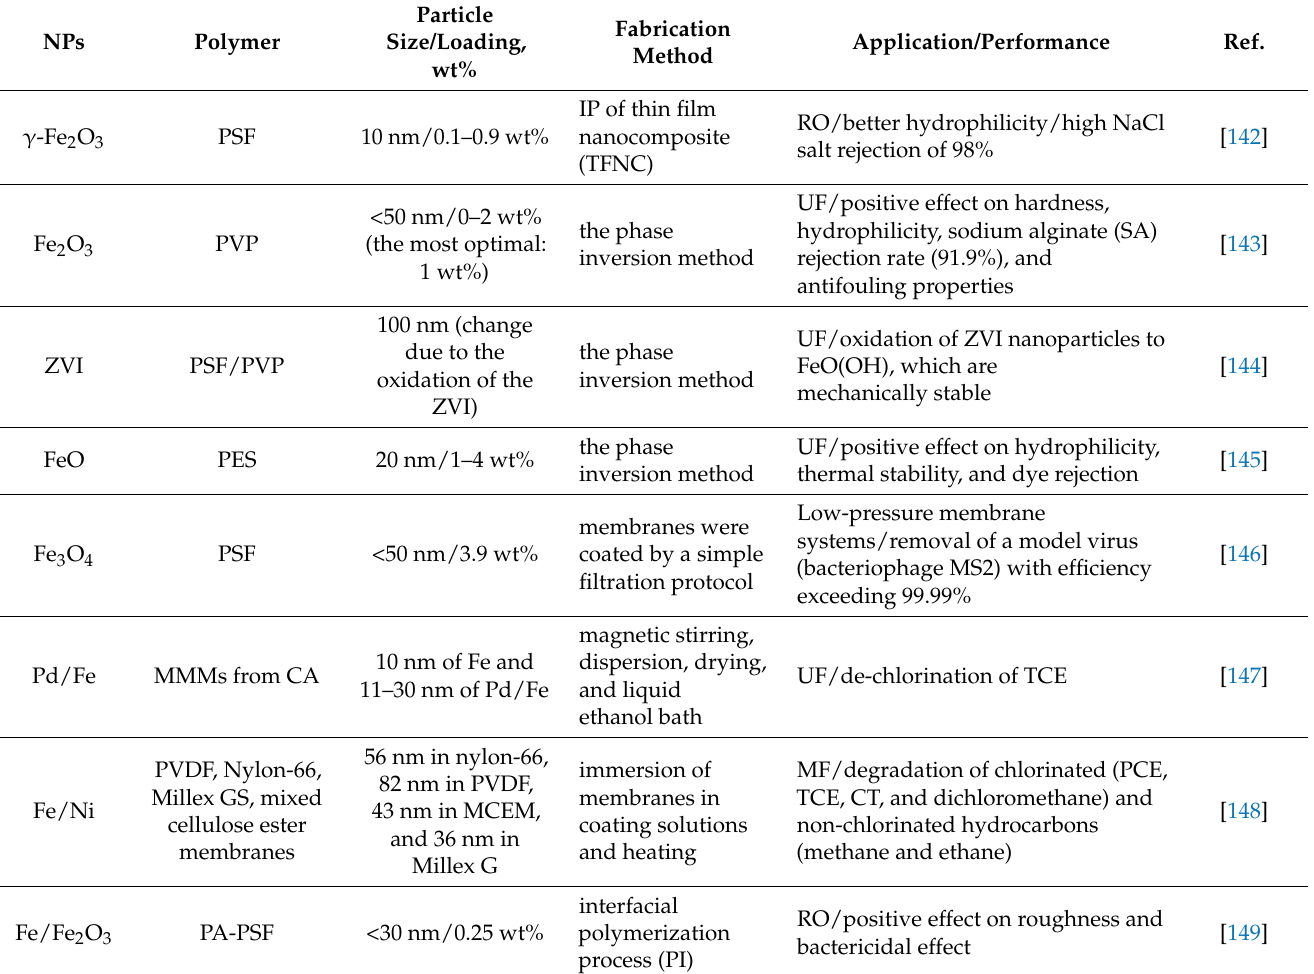
Table 6. Selected applications of various types of iron in